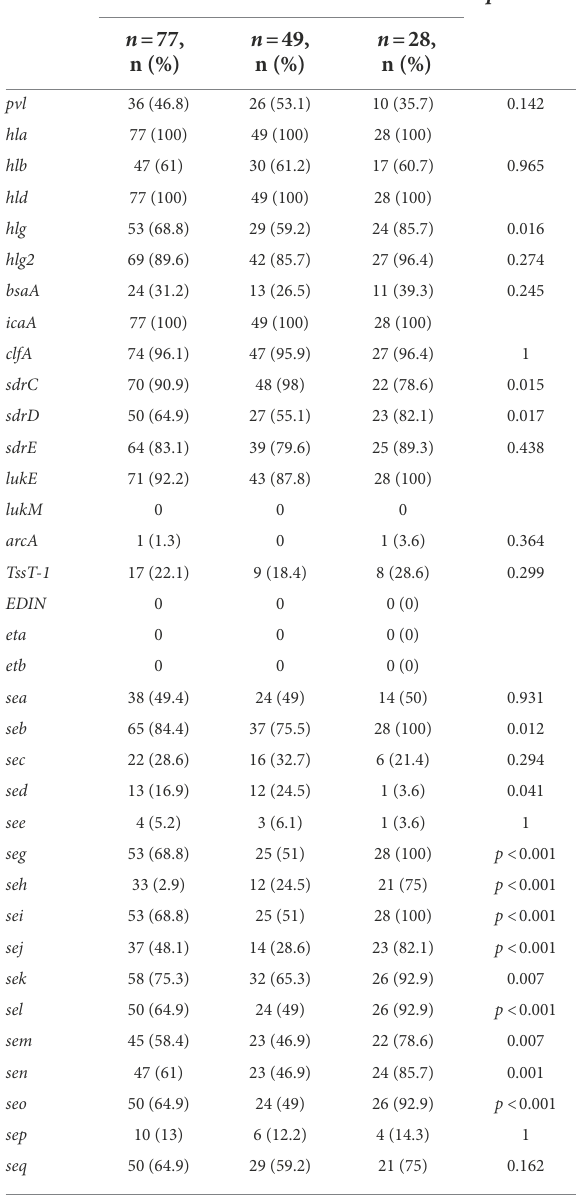
TABLE 5 Prevalence of virulence genes among community-acquired MRSA (CA-MRSA) and hospital-associated MRSA (HA-MRSA) isolates. S .